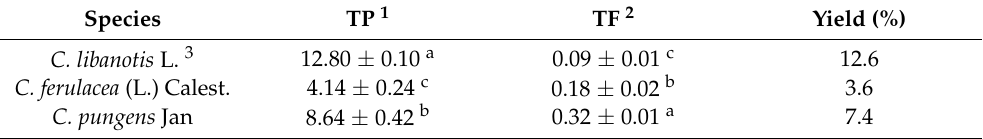
Table 1. Determination of yield, total phenolic and flavonoid content of investigated Cachrys species. Species TP